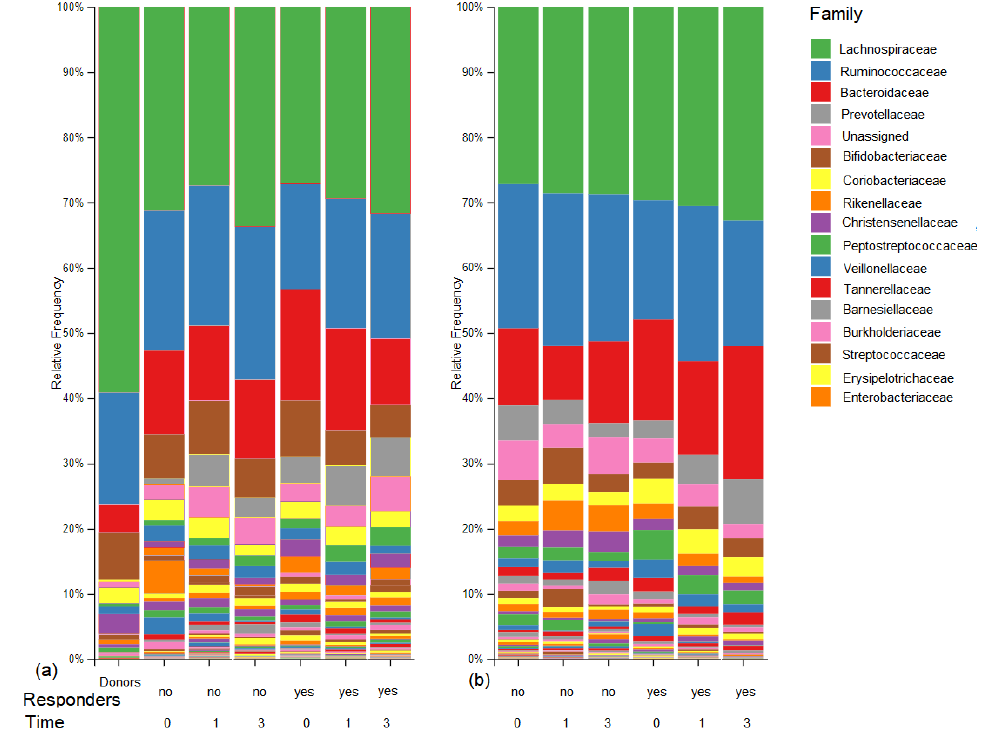
Figure 4. Relative abundance of fecal bacteria at the family level in all 135 samples from 35 patients with left-sided ulcerative colitis treated by ( a ) fecal microbial transplantation or ( b ) aminosalicylic acid. Donor profiles are shown in ( a ). The results are grouped by responsiveness to the treatment (yes/no) and the time of collection: 0 (before treatment), 1 (2–4 weeks after treatment), and 3 (12 weeks after